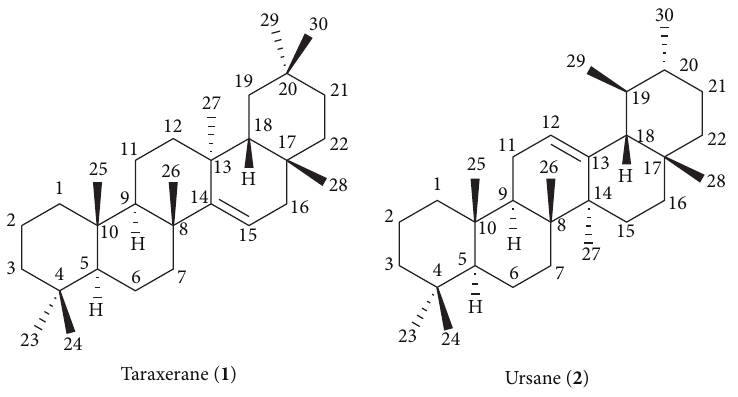
Figure 2: The carbon skeleton of taraxerane and ursane.